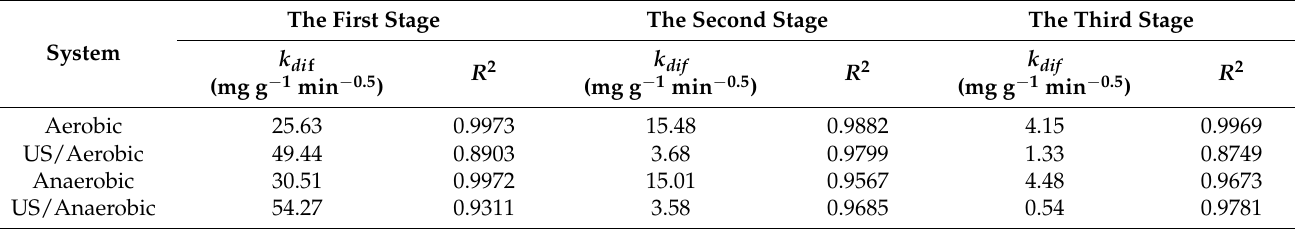
Figure 2. ( a ) Effects of ultrasonic pre-reatment: Removal efficiency, ( b ) concentration of Fe(II) in solution during sonication, ( c ) PSO model fitting results, and ( d ) intraparticle diffusion model fitting results. Experimental conditions: Temperature, 30 °C; pH = 5; initial concentration, 10 mg L − 1 ; dosage of nZVI/rGO, 0.1 g L − 1 ; ultrasonic frequency = 40 kHz. Table 4. Parameters of the intraparticle diffusion models in different